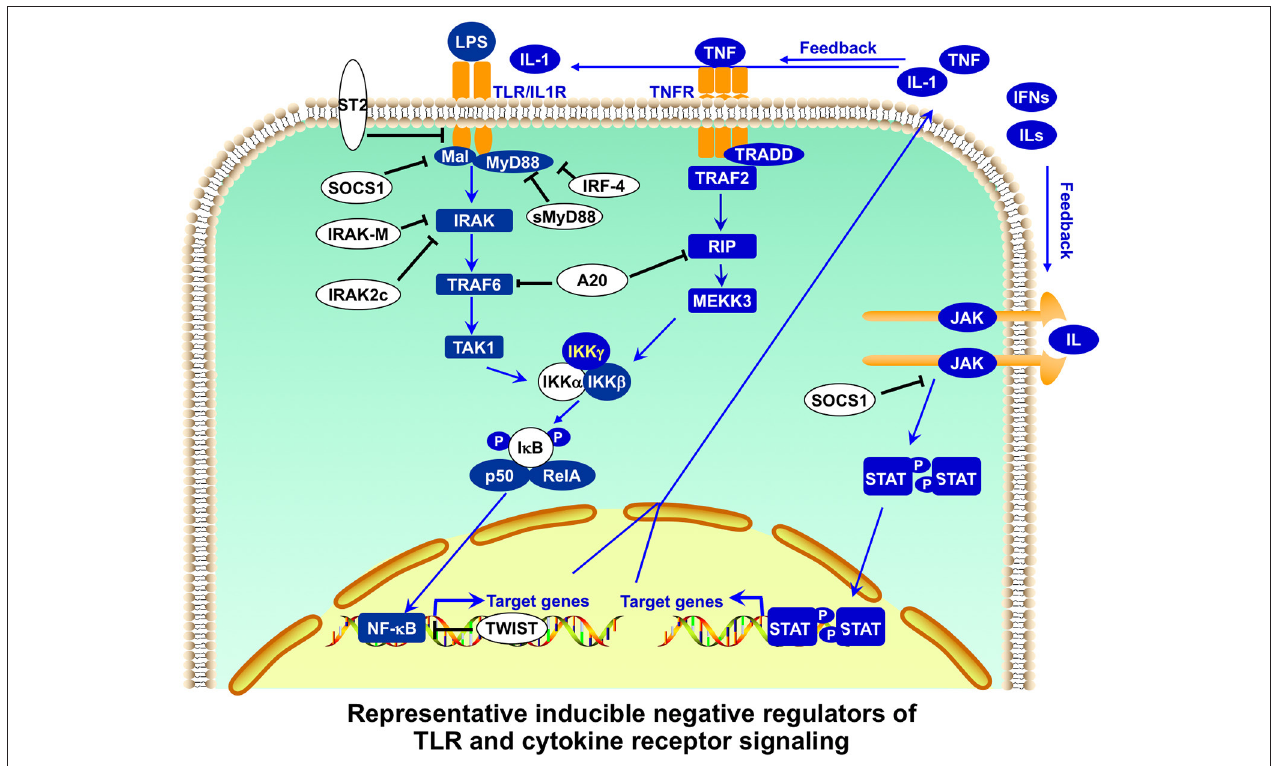
FIGURE 4 | Representative inducible negative regulators of TLR and cytokine receptor signaling in APCs. Toll-like receptor (TLR) signaling is further regulated by inducible negative regulators in a feedback manner. Membrane-bound ST2 interacts with MyD88 and Mal, and sequesters MyD88-dependent nuclear factor- κ B (NF- κ B) from activation. MyD88s (the short form of MyD88) antagonizes MyD88 functions. Intracellular IRAKM (interleukin-1 (IL-1) receptor-associated kinase M) inhibits the dissociation of IRAK-IRAK4 and subsequent formation of IRAK-TRAF6. SOCS1 promotes the ubiquitination of Mal for degradation. A20 has dual functions of ubiquitination and deubiquitination of RIP and TRAF6 (tumor-necrosis factor-receptor-associated factor 6) for their degradation, inhibiting both TLR and TNFR signaling. Transcription repressor Twist-2 inhibits the transcription of NF- κ B-targeted genes. Cytokine receptor signaling is also regulated by inducible